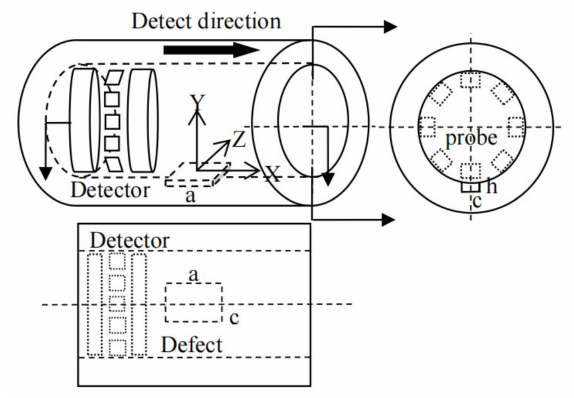
Figure 1. Schematic diagram of MFL internal detection